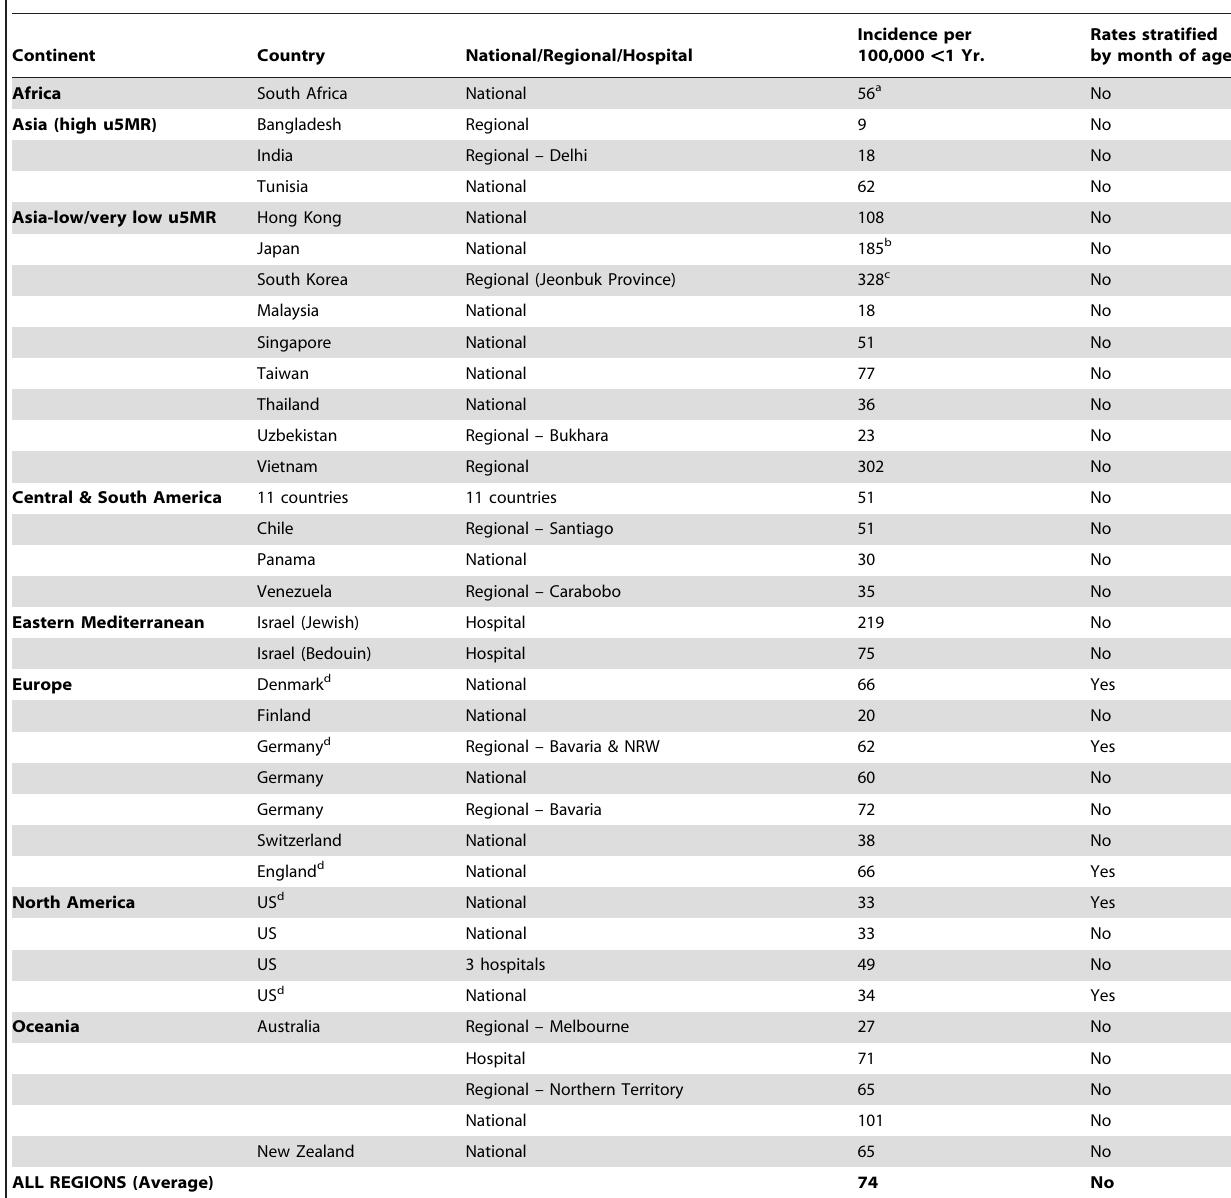
Table 2. Intussusception incidence among children , 1 year of age by region.